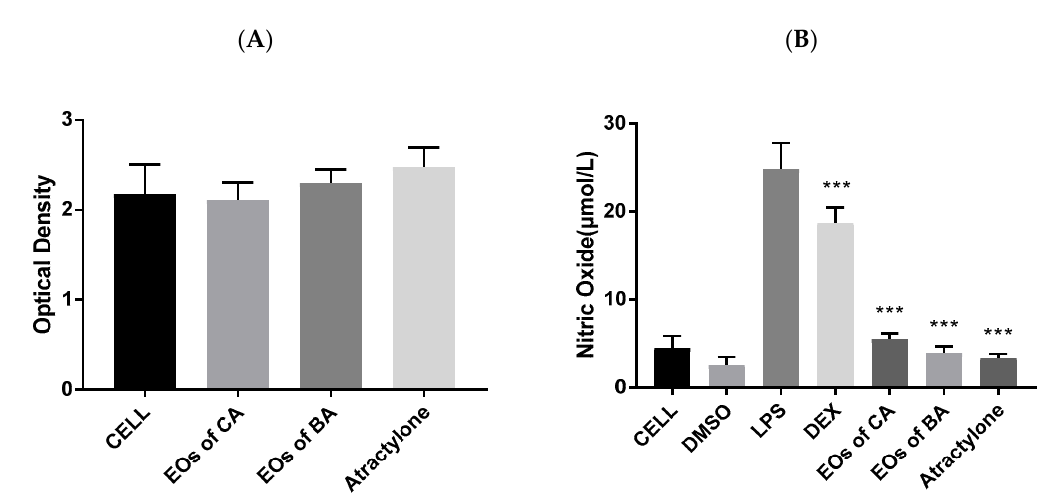
Figure 4. ( A ) E ff ects of EOs of CA, EOs of BA, and atractylone on the viability of ANA-1 cells ( n = 3). cell: blank control; cell + EOs of CA, EOs of BA and atractylone: EOs of CA, EOs of BA and atractylone at 50 µ g · mL − 1 respectively. ( B ) NO inhibitory e ff ects of EOs of CA, EOs of BA and atractylone on LPS-activated ANA-1 cells ( n = 3). cell: blank control; DMSO: DMSO at the concentrations of 1:2500; LPS: LPS control; DEX: positive control of DEX at 10 µ g · mL − 1 ; EOs of CA, EOs of BA and atractylone: EOs of CA, EOs of BA and atractylone at 50 µ g · mL − 1 respectively; ***: p < 0.001 vs. LPS.